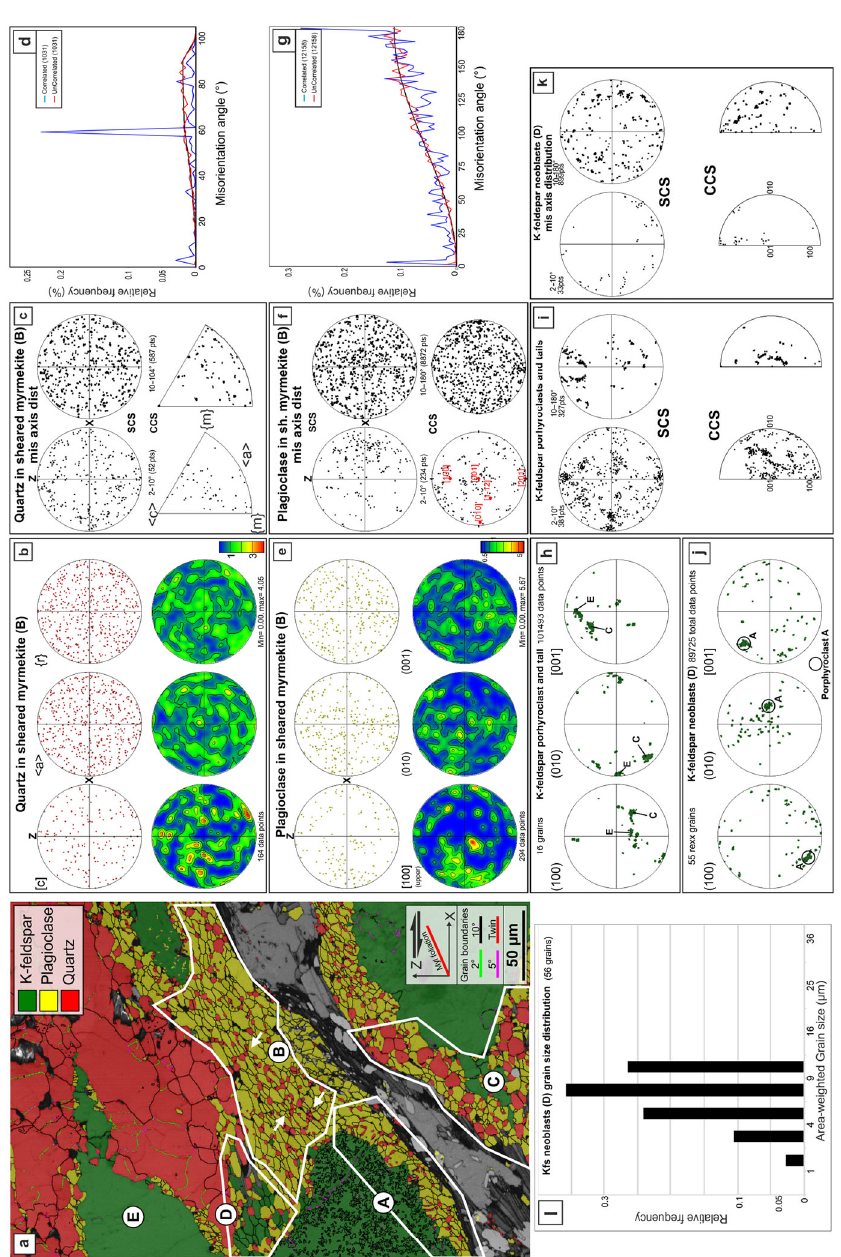
Figure 4. EBSD map and crystallographic orientation data of pristine and sheared myrmekite of Fig. 1e. (a) EBSD phase map including areas (A, B, C, D) selected for grain size analysis and phase distribution analysis. (b) Pole figures for Qtz from the sheared myrmekite of Area B. Upper row: scattered data. Lower row: contoured data. (c) Misorientation axis distributions for Qtz in sample (upper row) and crystal (lower row) coordinate system. (d) Misorientation angle distribution for Qtz. (e) Pole figures for Plg from sheared myrmekite of Area B. Upper row: scattered data. Lower row: contoured data. In this case, the [100] Plg pole figure is reported in upper hemisphere, where the maximum has been observed. (f) Misorientation axis distributions for Plg in sample (upper row) and crystal (lower row) coordinate system. (g) Misorientation angle distribution for Plg. (h) Pole figures of the crystallographic orientation of Kfs porphyroclasts included in Areas C and E and respective tails. (i) Misorientation axis distributions in sample (upper row) and crystal (lower row) coordinate system for porphyroclasts and tails. (j) Pole figures of the crystallographic orientation of Kfs porphyroclast A and Kfs neoblasts in the strain shadow (Area D). (k) Misorientation axis distributions in sample (upper row) and crystal (lower row) coordinate system for Kfs neoblasts. (l) Grain size distribution for the Kfs